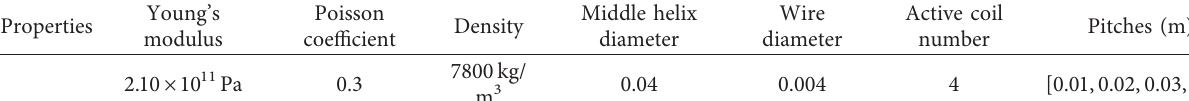
Table 1: Geometrical properties and material properties of the variable pitch